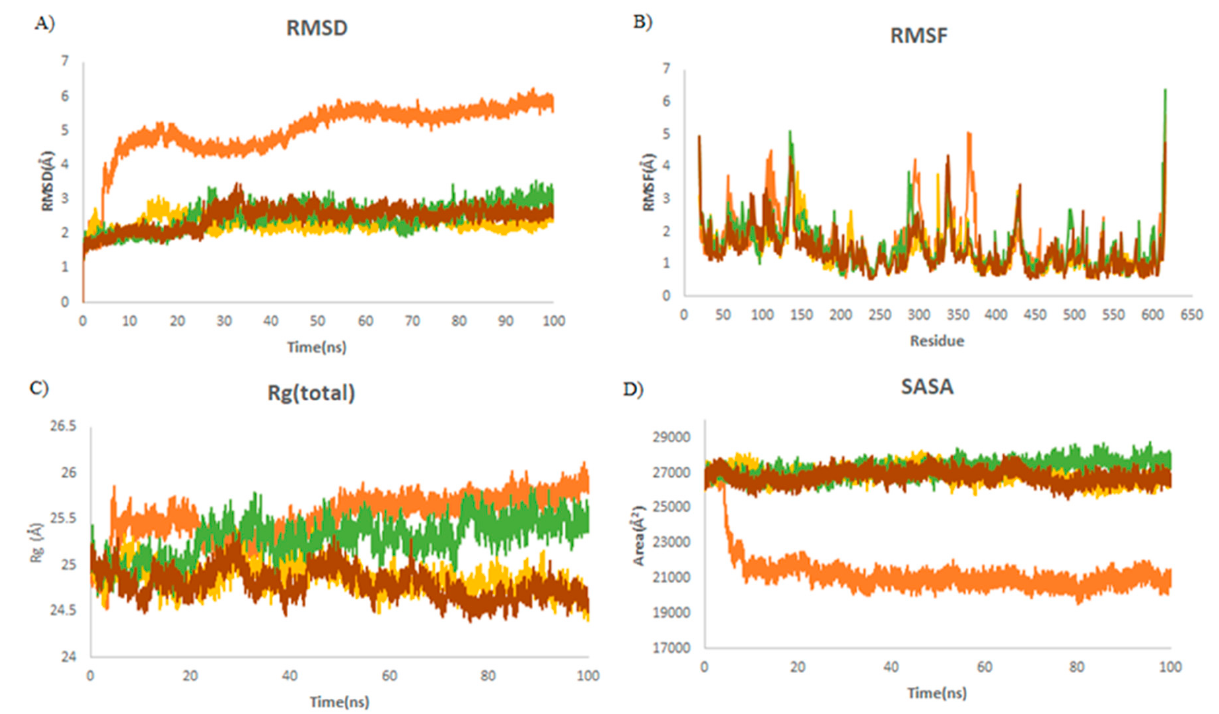
Figure 4. Structural dynamics of ACE2. ( A ) Root mean square deviation (RMSD), ( B ) root mean square fluctuations (RMSF), ( C ) radius of gyration (Rg) plot, and ( D ) solvent-accessible surface area (SASA). Orange color indicates ACE2-free form; yellow, green, and brown indicate ACE2 in a complex with griseofulvin, A9, and A3, respectively. Table 3. The average of RMSD, RMSF, Rg, and SASA for ACE2 during the last 20 ns of MD simula- tions. PubChem IDs of derivatives A9 and A3 are 132286359 and 46844082, respectively.